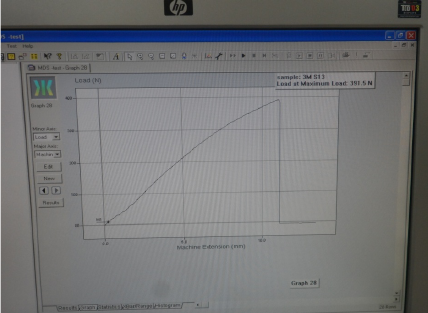
Figure 8. Computer generated graph according to the maximum force of separa3on